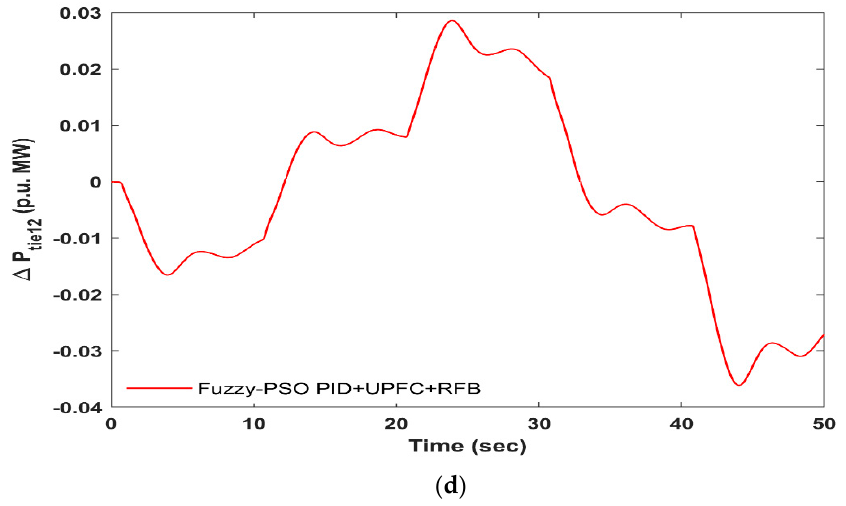
Figure 10. ( a – d ) LFC results for continuous load alteration for 50 s.